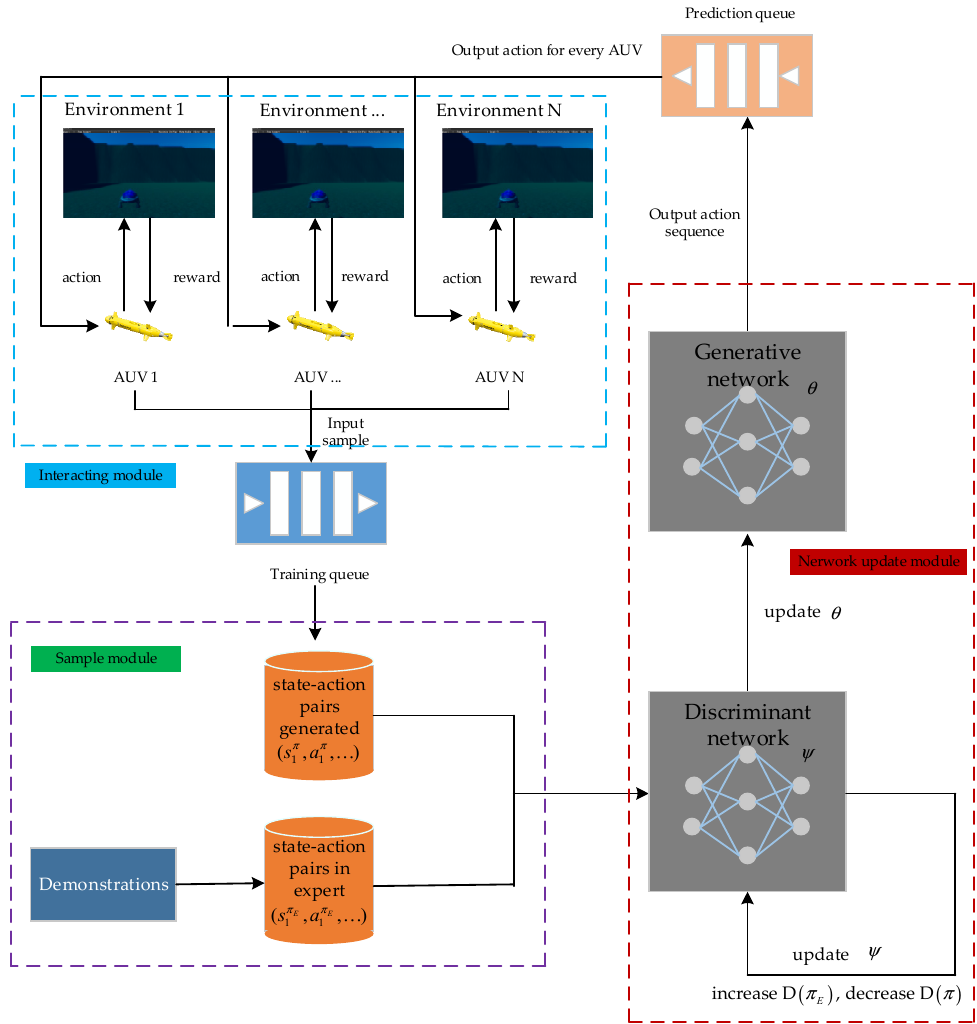
Figure 3. Structure diagram of MAG algorithm.